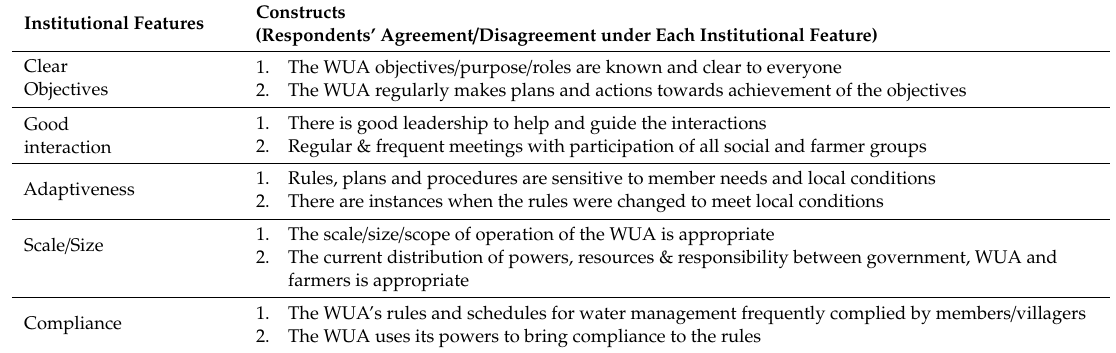
Table A1. Di ff erent institutional features and their constructs.